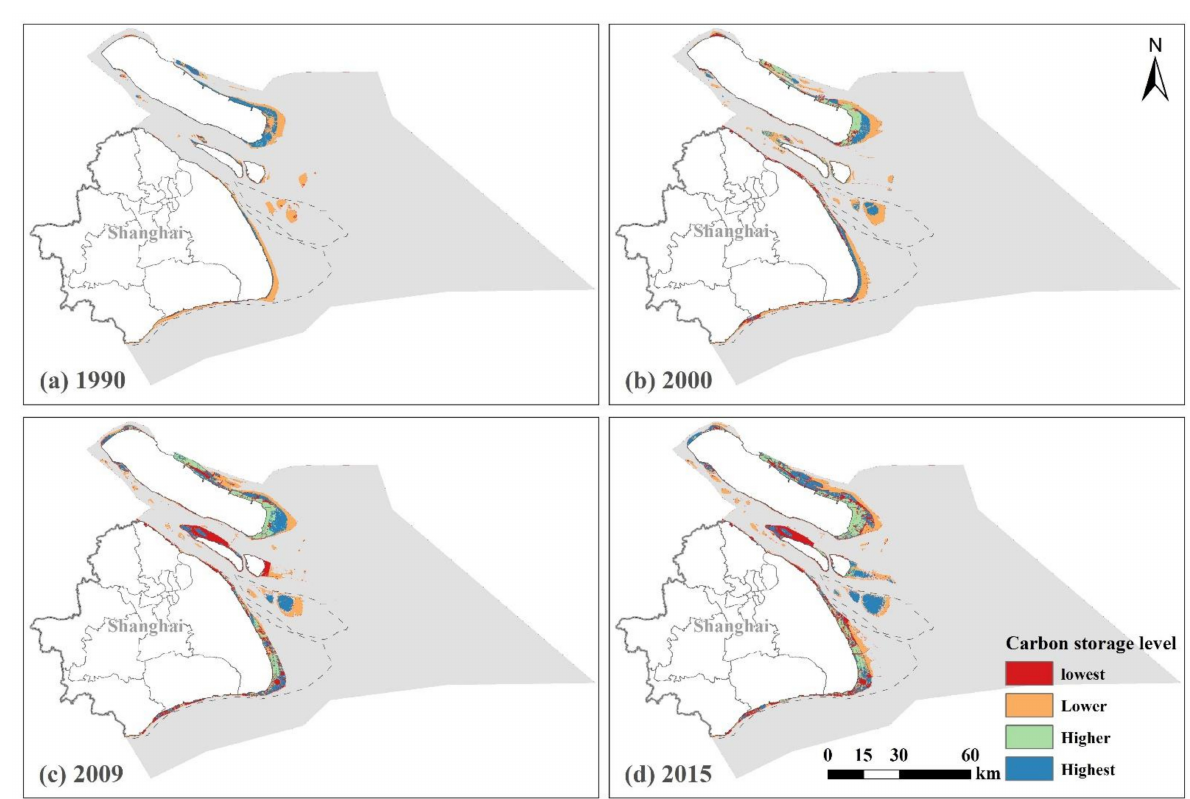
Figure 5. The spatiotemporal distribution of the four levels (Highest, Higher, Lower and Lowest) of blue carbon storage in the Shanghai coastal area during 1990–2015. ( a ) The spatial distribution of the four levels of coastal blue carbon storage in the study area in 1990. ( b ) The spatial distribution of the four levels of coastal blue carbon storage in the study area in 2000. ( c ) The spatial distribution of the four levels of coastal blue carbon storage in the study area in 2009. ( d ) The spatial distribution of the four levels of coastal blue carbon storage in the study area in